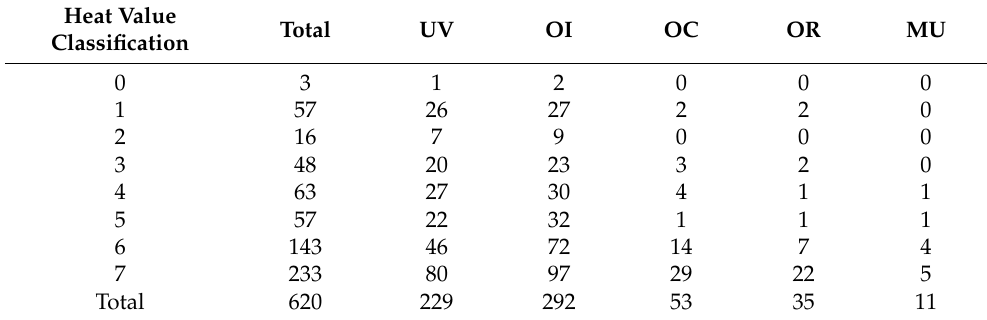
Table 7. Number of UR projects with different population heat values.